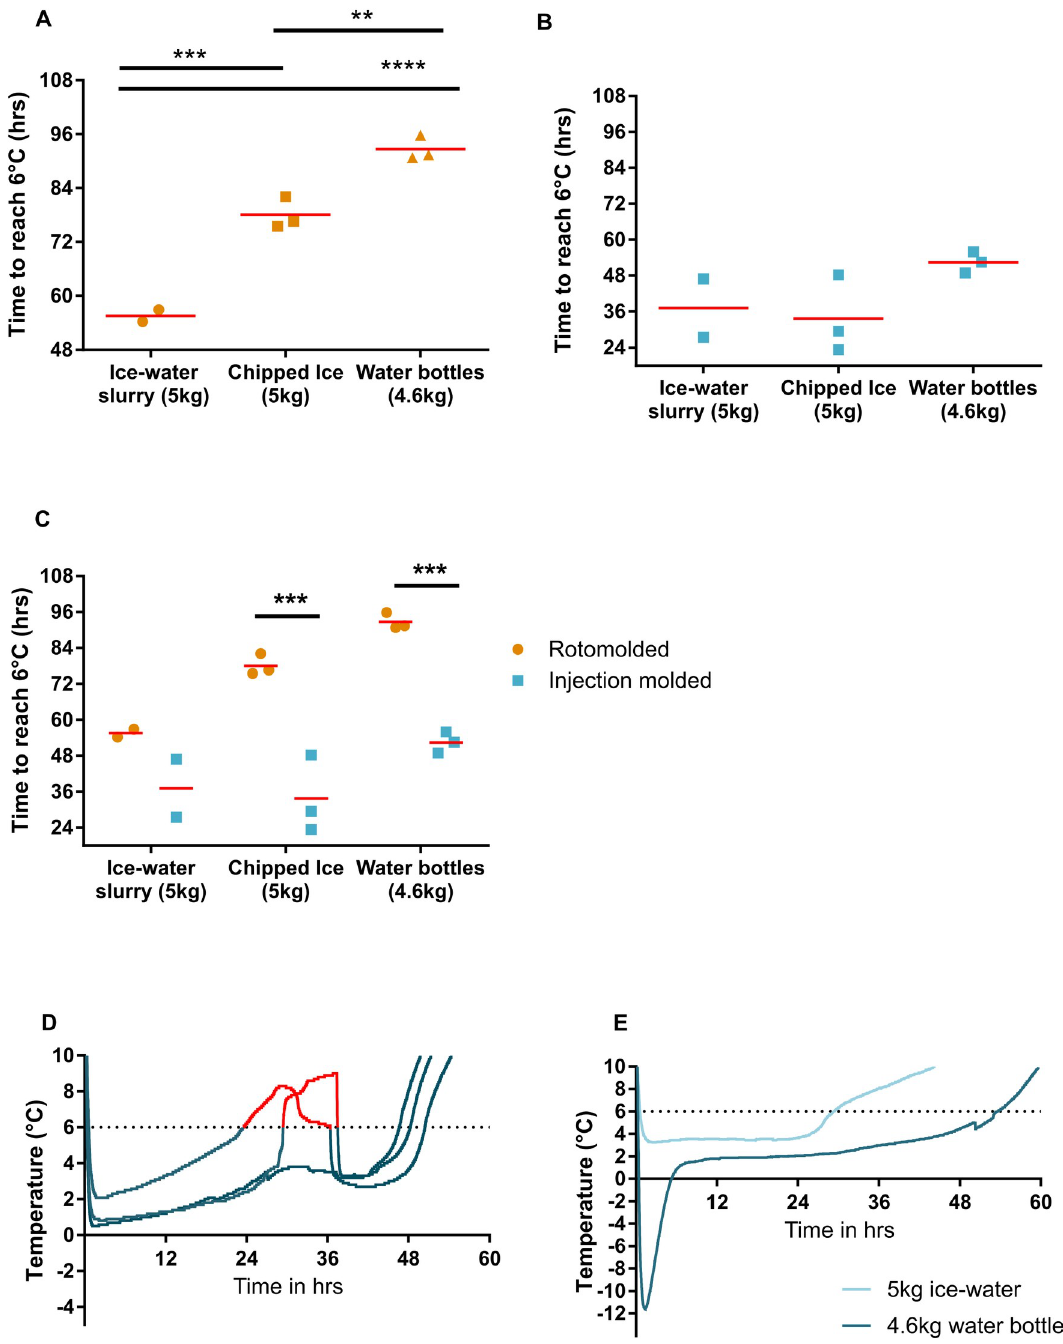
Fig 2. Different types of ice vary in their cold times. (A) Cold time for rotomolded cooler #14 with 5 kg of ice-water, chipped ice, and solid blocks of ice. Each point represents a single run and the red bar represents the mean. Statistical significance determined by a One-way ANOVA with Tukey’s multiple comparison test. �� P-value � 0.01, ��� P-value � 0.001, ���� P-value � 0.0001. (B) Cold time for injection molded cooler #10 with 5 kg of ice-water, chipped ice, and solid blocks of ice. Each point represents a single run and the red bar represents the mean. (C) Cold time for varying types of ice in rotomolded cooler #14 (orange) and injection molded cooler #10 (blue). Red bar represents the mean. Statistical significance determined by One-way ANOVA with Holm-Sˇida´k multiple comparison test. ��� P-value � 0.001. (D) Temperature curves for injection molded cooler #10 in chipped ice. Dotted line is 6˚C cutoff and red section of the line highlights time exceeding 6˚C. (E) Temperature curves for injection molded cooler #10 with ice-water (light blue) and frozen water bottles (dark